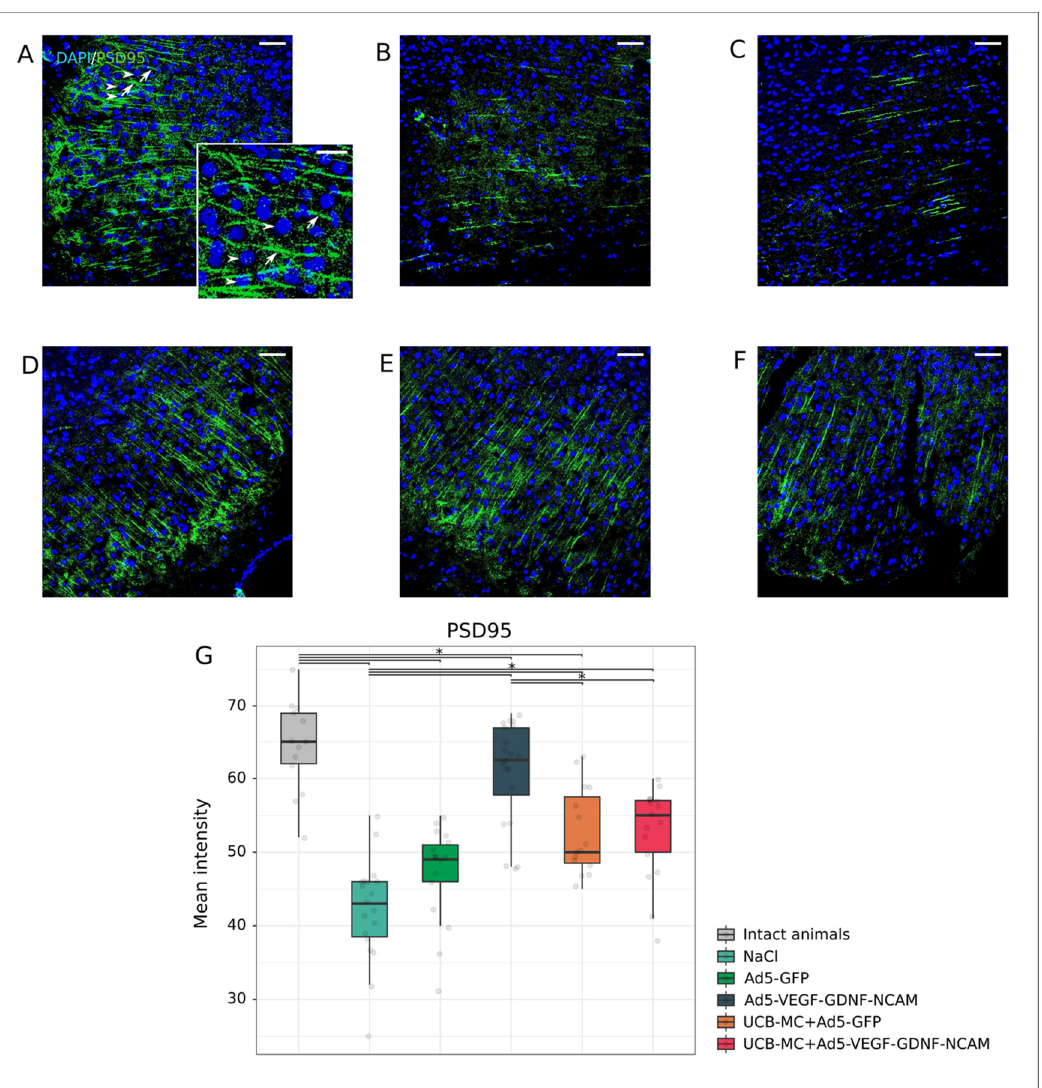
Figure 9. Immunoexpression of PSD95 in the rat brain cortex 21 days after the middle cerebral artery occlusion. Immunofluorescent staining with antibody to postsynaptic membrane protein PSD95 in intact ( A ), control NaCl ( B ) and Ad5-GFP ( C ), and therapeutic UCB-MC+Ad5-GFP ( D ), Ad5-VEGF-GDNF-NCAM ( E ) and UCB-MC + Ad5-VEGF-GDNF-NCAM ( F ) groups. Arrows indicate PSD95 (green glow) in neurons. Arrowheads point to cell nuclei visualized using DAPI (blue glow). Scale bar in ( A – F ) = 50 µm; scale bar in the insert = 20 µm. ( G )—Comparative analysis of fluorescence intensity level of PSD95 in experimental groups; *— p < 0.05.